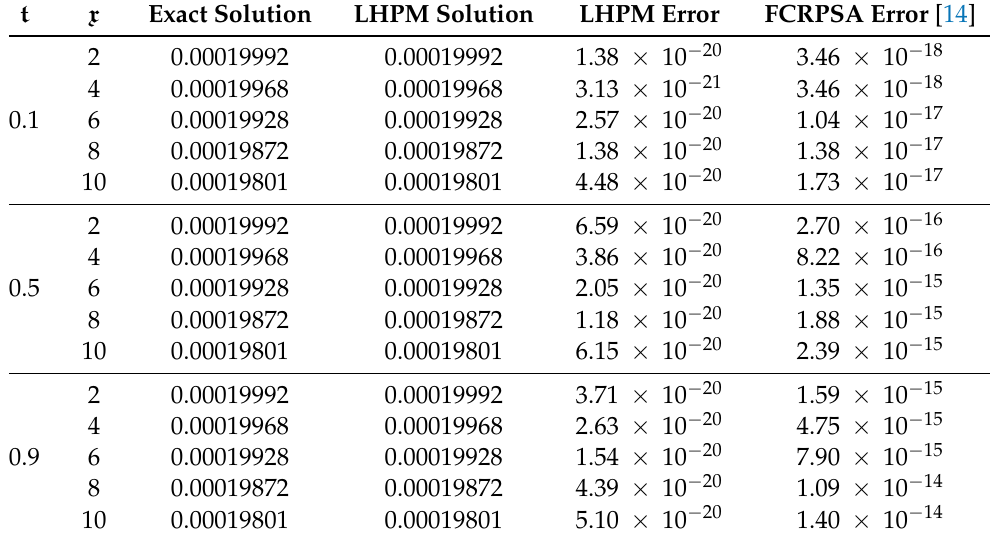
Table 3. Comparison of LHPM and FCRPSA errors in Example 1 when β = 1 and k = 0.01.